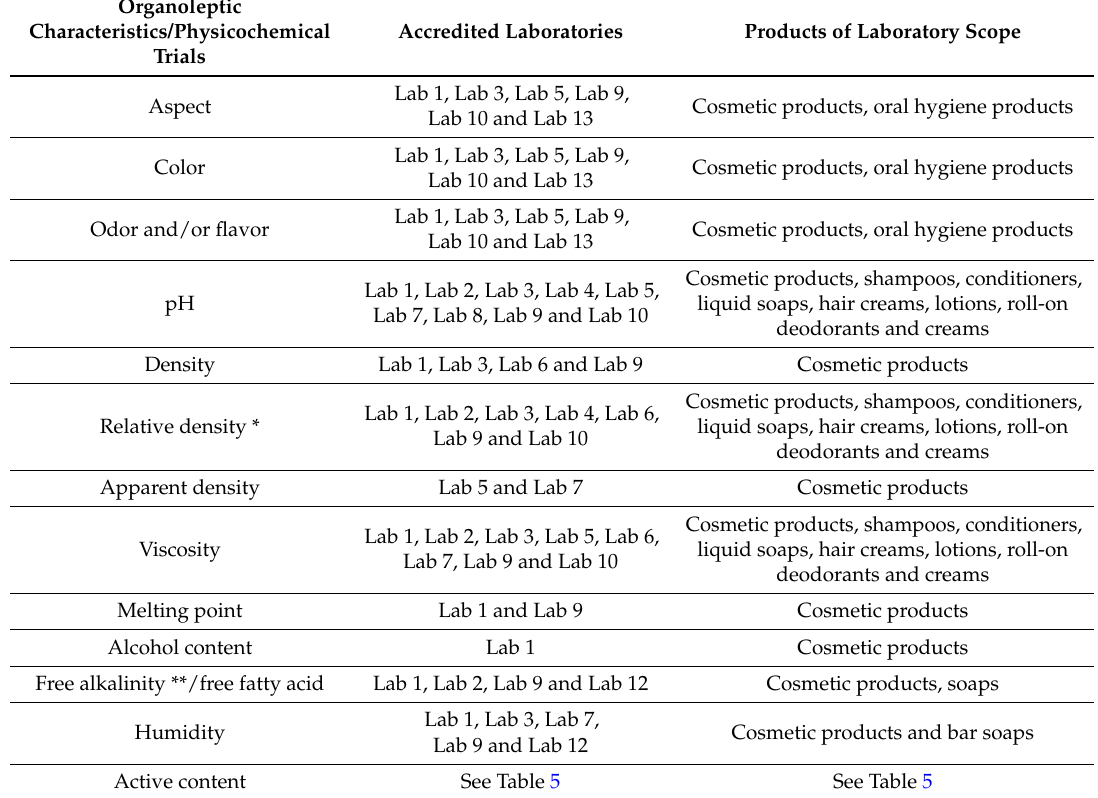
Table 4. Accredited Laboratories for the verification of organoleptic characteristics and physicochemical trials in cosmetics suggested by ANVISA